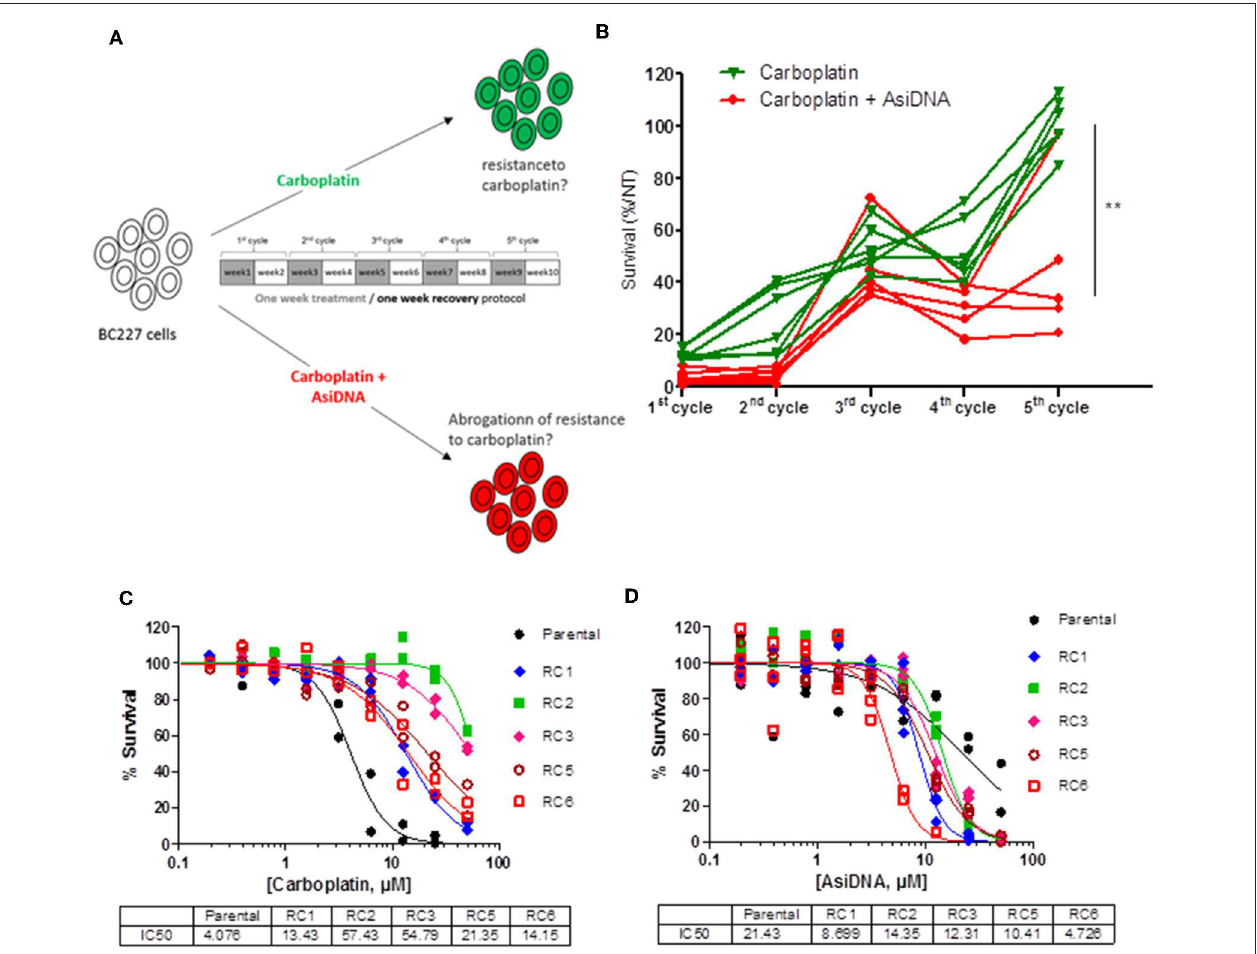
FIGURE 7 | Effect of AsiDNA on the emergence of resistance to carboplatin. Cells were treated for 1 week and grown without treatment for an additional week for one to five cycles. (A) Schedule of treatment. Gray square: weeks of treatment with 7 µ M carboplatin ± 2.5 µ M AsiDNA; white square: weeks without treatment. (B) Survival to each cycle of treatment was monitored in 10 independent BC227 populations treated with either carboplatin (green triangles) or carboplatin + AsiDNA (red circles). (C,D) Survival of carboplatin-resistant populations (RC) vs. parental cells after 1 week treatment with (C) carboplatin or (D) AsiDNA. Survival was estimated by the ratio of treated cells on non-treated cells after 1-week treatment. ** P <